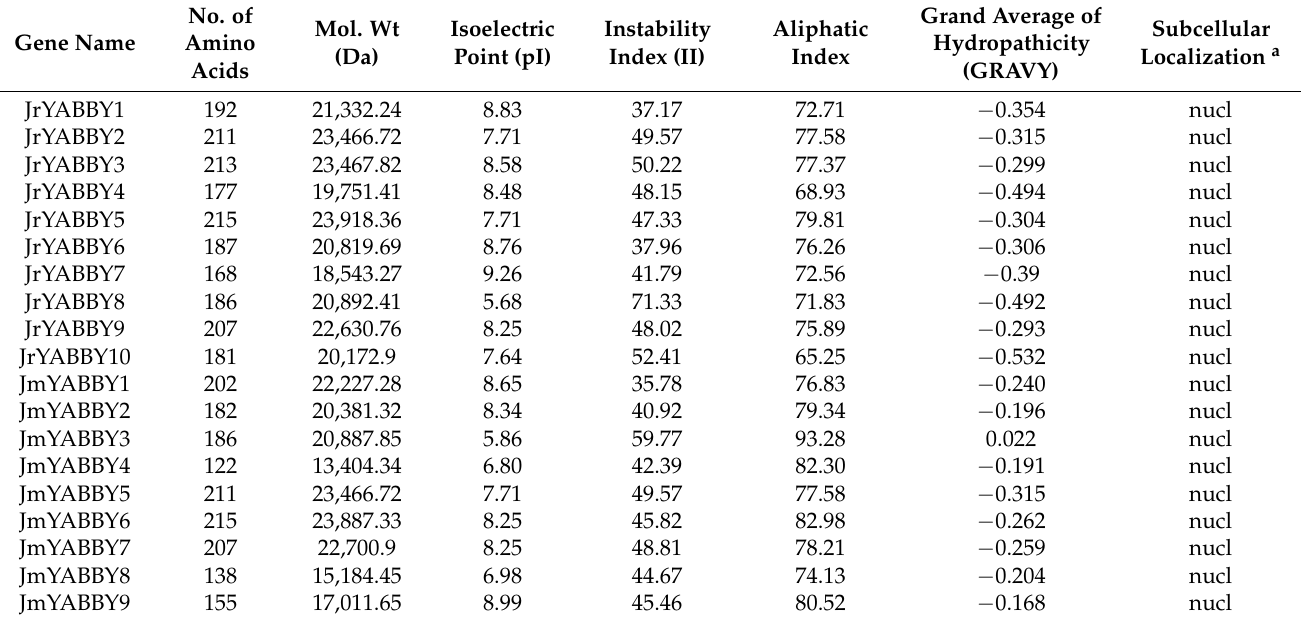
Table 1. Predicted protein data of YABBY in J. regia and J. mandshurica